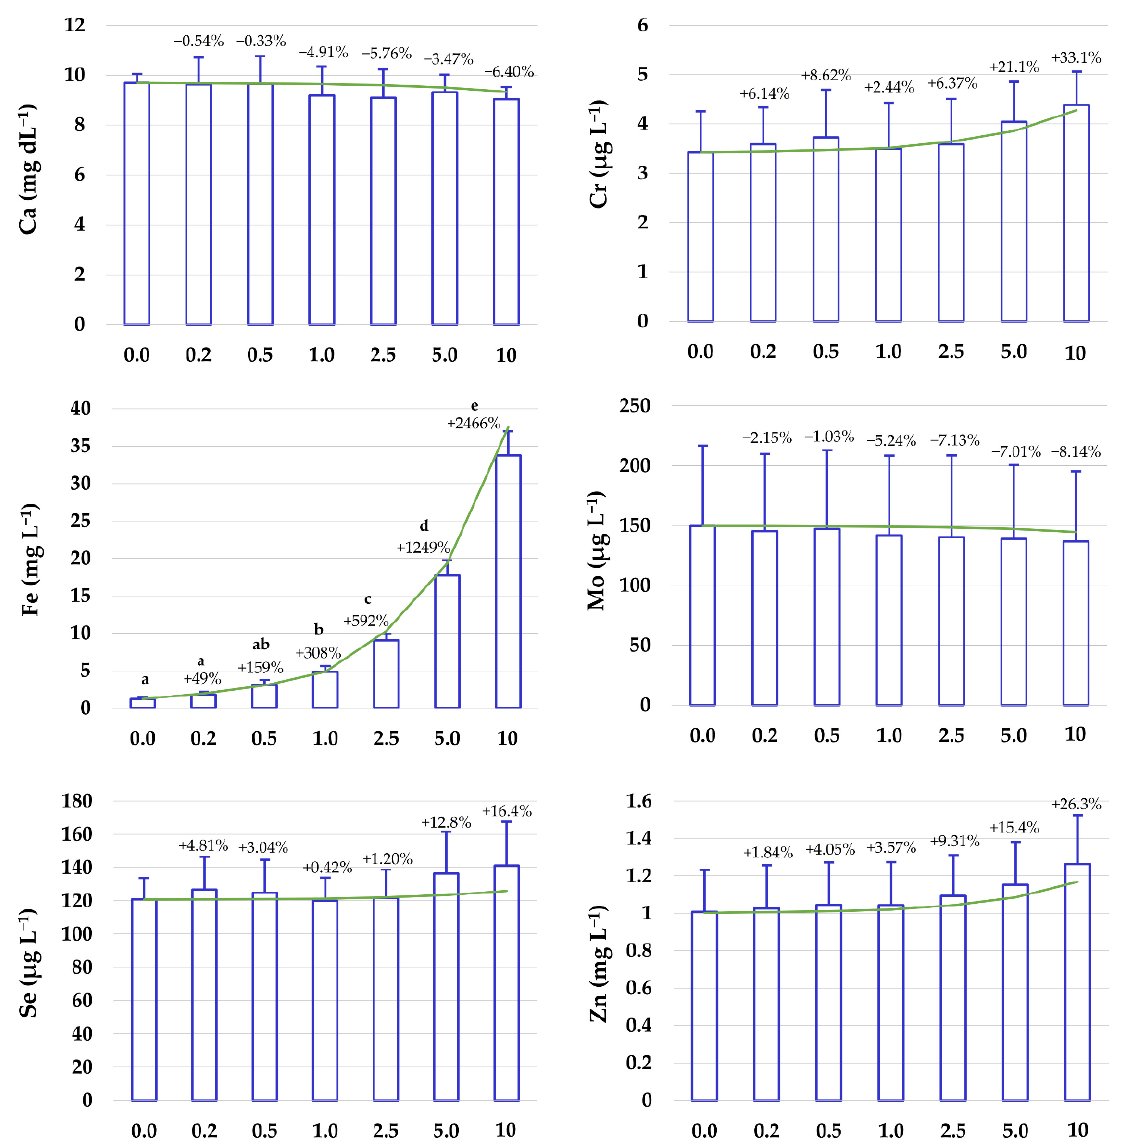
Figure 2. Effects of in vitro haemolysis on macro and micromineral concentrations in serum. Details of the haemolysate-spiked sample preparation are given in the text and summarised in Table 2. The green lines indicate the theoretical concentrations calculated considering the mean mineral concentrations in serum and whole blood. For each haemolysis degree, different letters indicate statistically significant differences. Percentage variation is expressed relative to the blank, non-spiked serum.